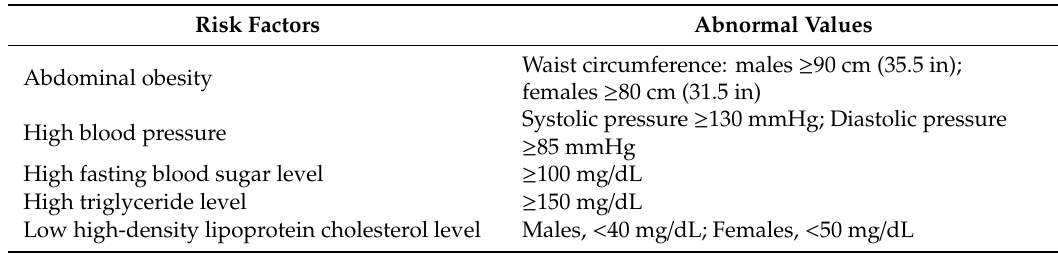
Table 1. Determination standard for metabolic